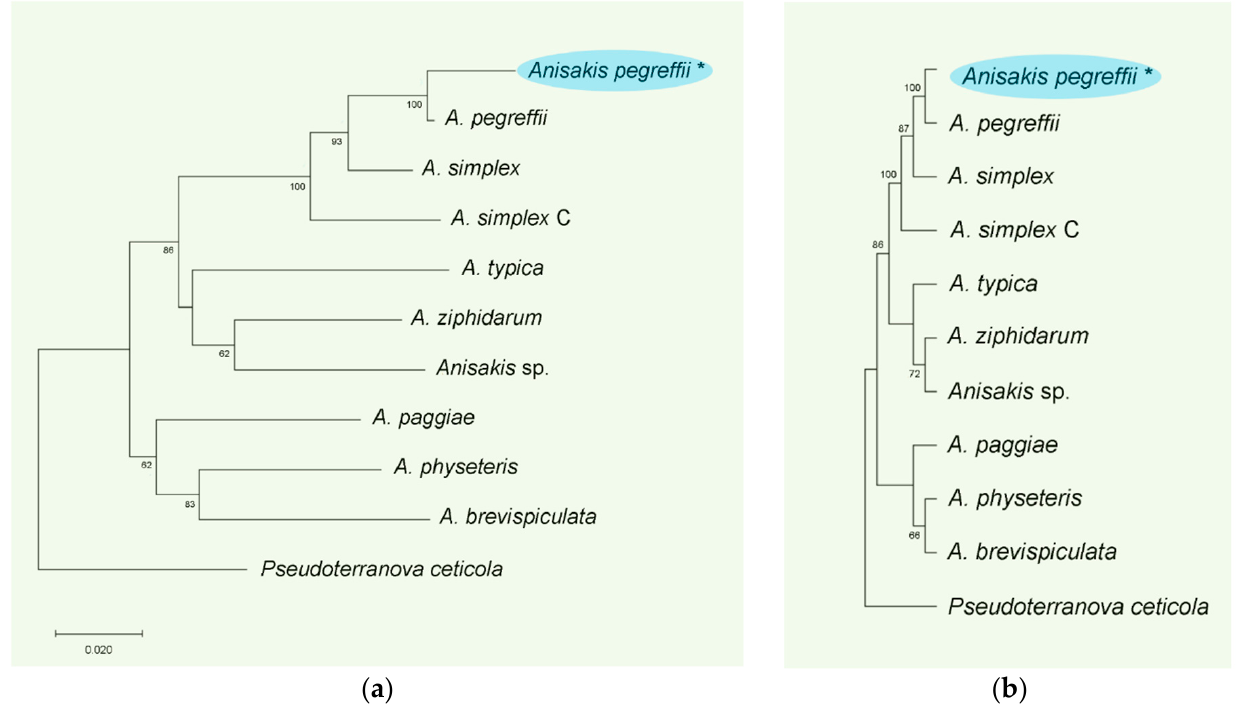
Figure 6. Phylogenetic relationships among Anisakis species as inferred by Neighbor-Joining (NJ) analysis of the cox2 gene. The accession numbers are as follows: A. simplex ( s. s .) (DQ116426), A. pegreffii (DQ116428), A. simplex C (DQ116429),